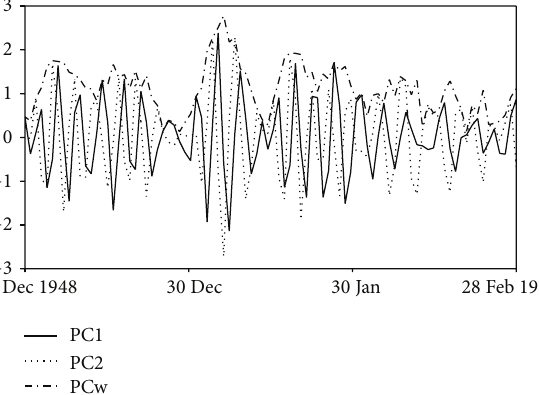
Figure 7: The PCw, PC1, and PC2 from 1 December 1948 to 28 February 1949 (solid line: PC1, pecked line: PC2, and dash-dot: PCw, unit: